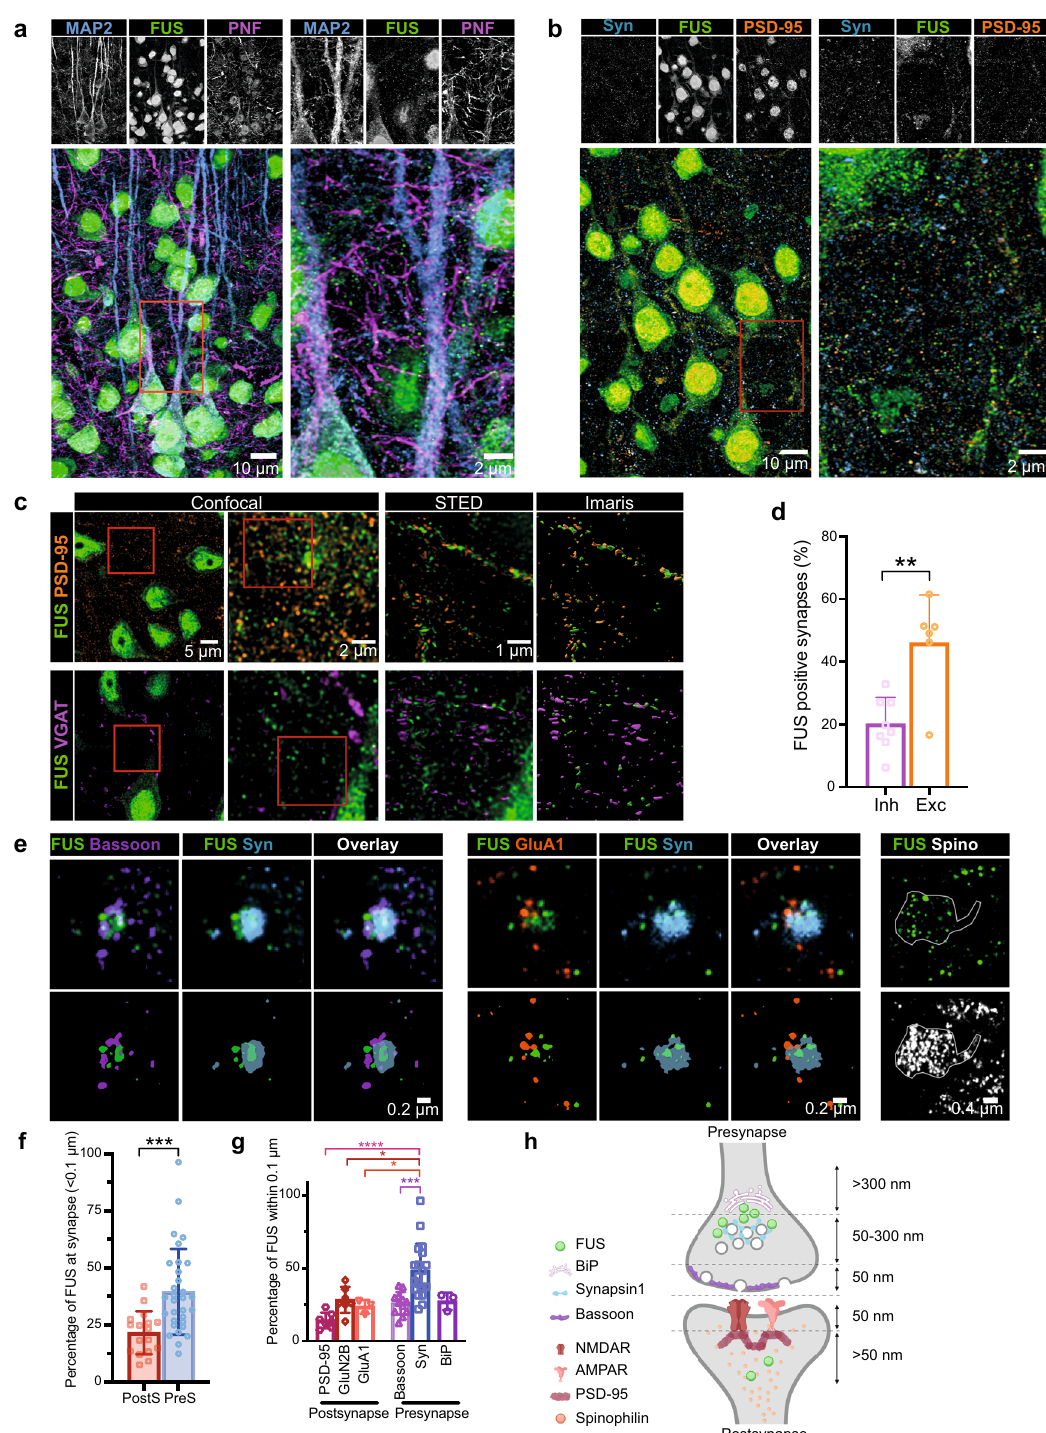
(Fig. 1h). These results are in line with the previously